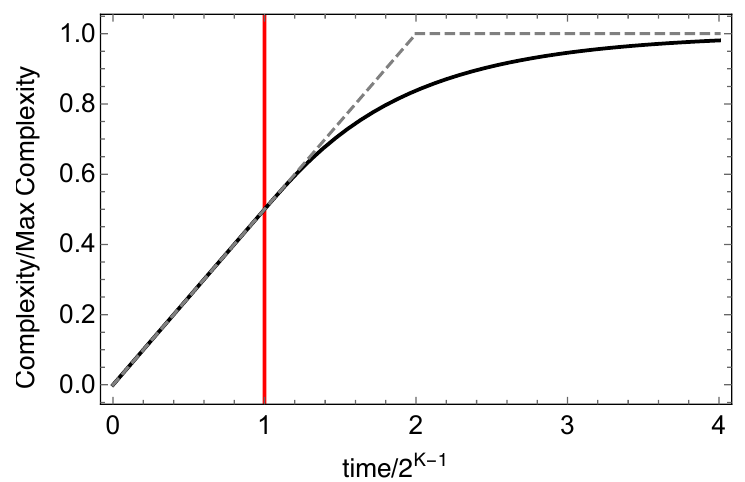
Figure 3 . The average complexity as a function of time in the random circuit model (solid black curve) de(cid:12)ned in the text. In the large K limit, there is a phase transition at t = 2 K (cid:0) 1 (indicated by the red line), where the second derivative jumps from 0 to a negative value. The dashed curve is what was conjectured in, e.g., (cid:12)gure 1 of